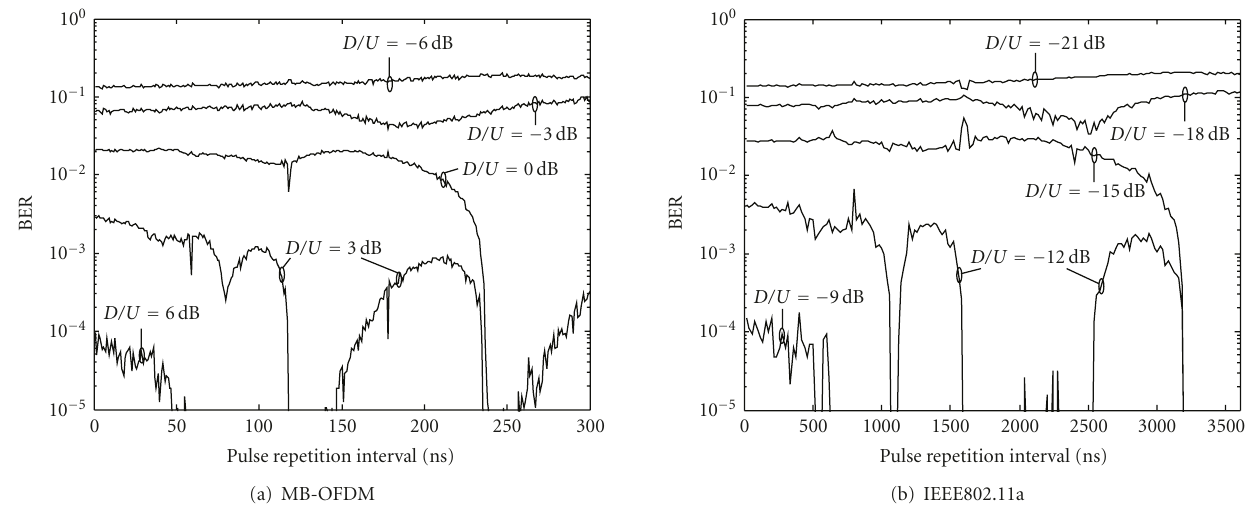
Figure 2: BER performance of OFDM interfered with by p-UWB for changing pulse repetition intervals ( E b /N 0 = inf.).